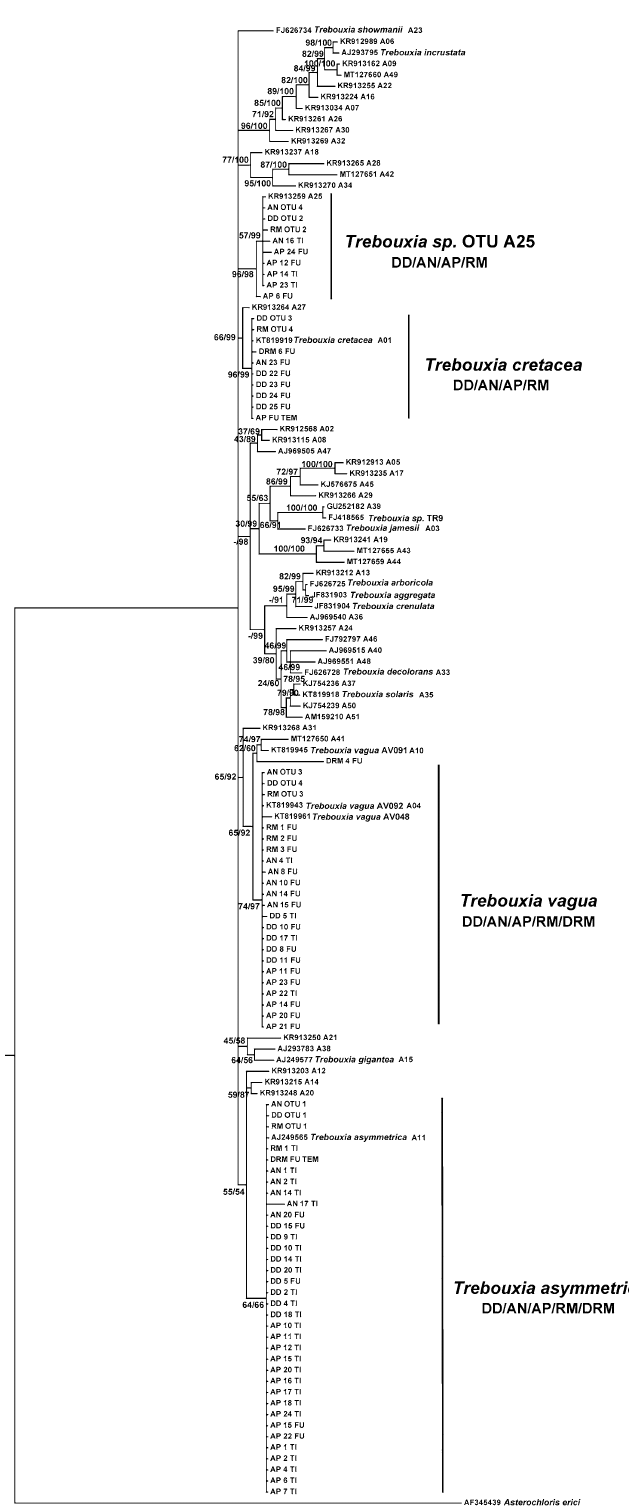
Figure 2. Trebouxia diversity revealed by Sanger sequencing and 454-pyrosequencing of Diploschistes diacapsis (DD), Acarospora nodulosa (AN), Acarospora placodiiformis (AP), Rhizocarpon malenconianum (RM) and Diplotomma rivas-martinezii (DRM). Rooted nrITS gene tree representing 134 Trebouxia sequences, including 57 OTUs from clade A described by Muggia et al. 110 and retrieved from GenBank. Pyrosequencing consensus sequences were labelled with the lichen species and code_number of the OTU. The sequence obtained from the specimen selected to characterize the ultrastructure with TEM is indicated. Values at nodes indicate statistical support estimated by two methods: bootstrap support (BS, RAxML analysis) and posterior probabilities (PP, MrBayes analysis). The scale bar shows the estimated number of substitutions per